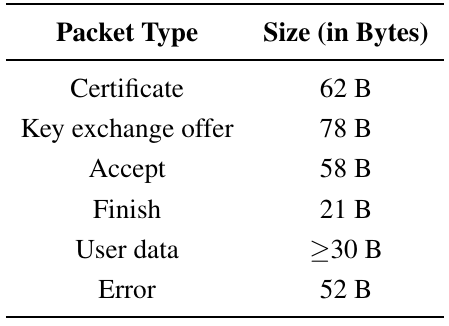
Table 1. The sizes of different packet types used in this